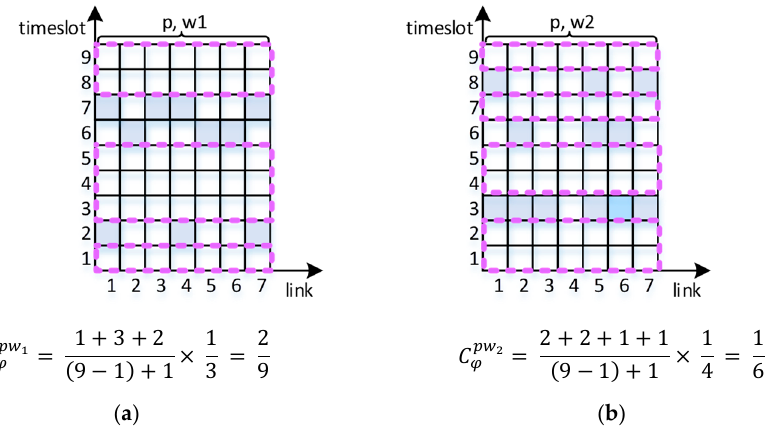
Figure 4. ( a ) Time continuous compactness (TCC) on wavelength 𝑤1 ; ( b ) TCC on wavelength 𝑤2 .